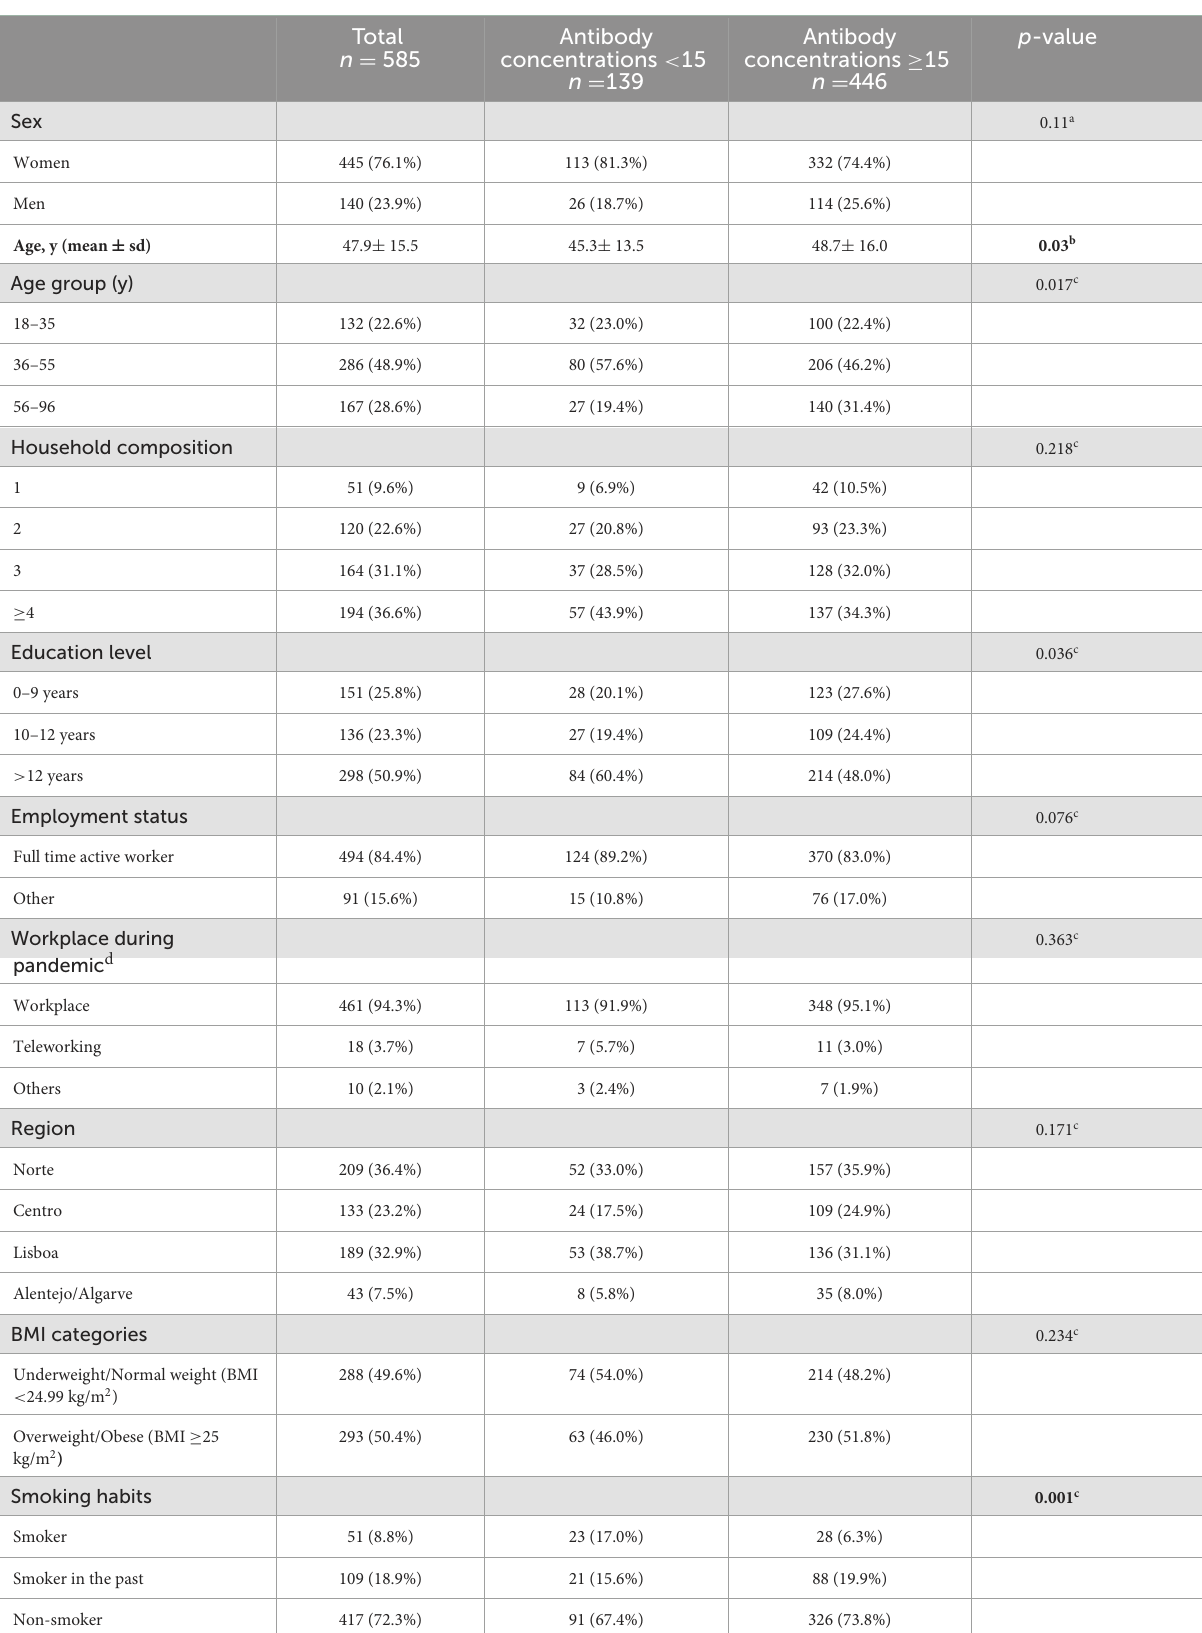
TABLE 1 Characteristics of the 585 participants at baseline, by IgG